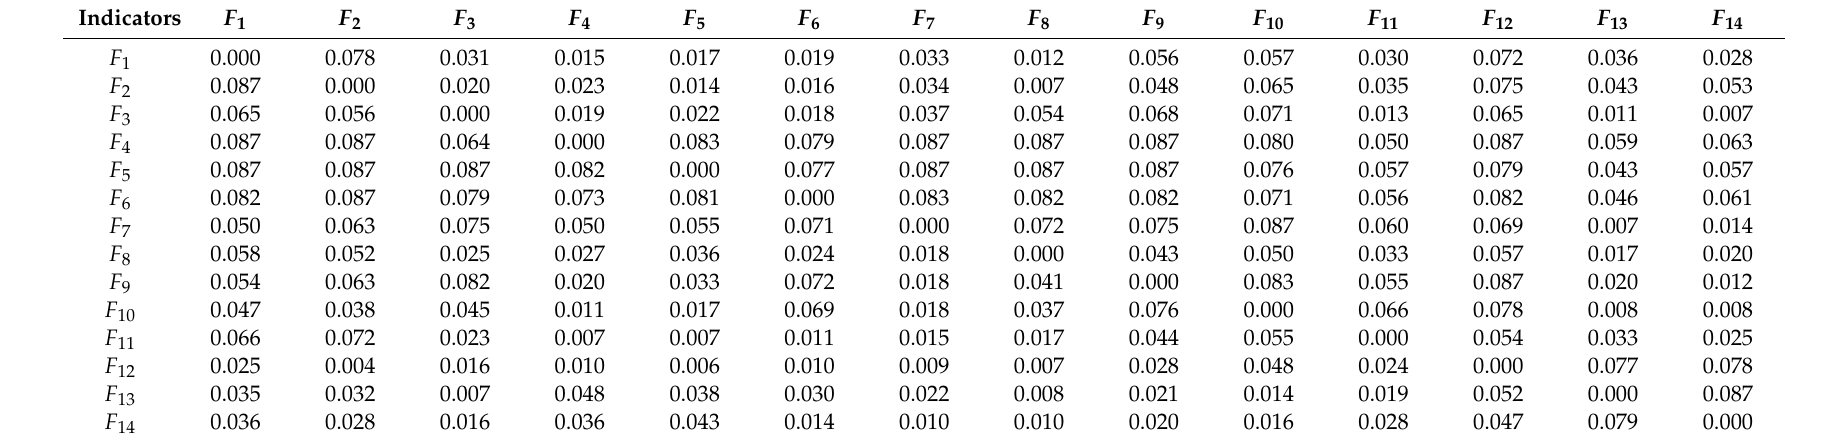
Table 5. The normalized direct influencing matrix X